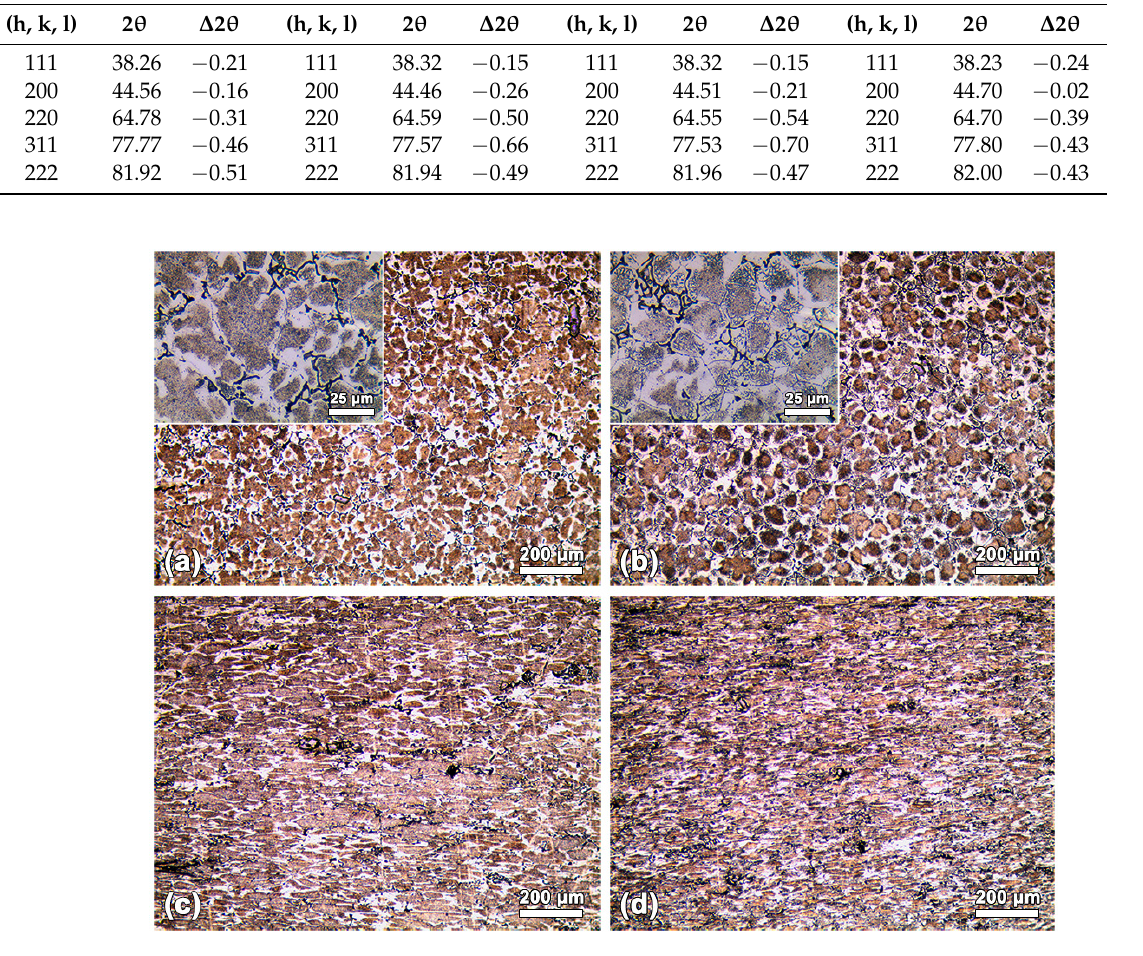
Table 3. Experimental and calculated 2 θ Angles with the corresponding differences for the Al phase. Al (Ref.)